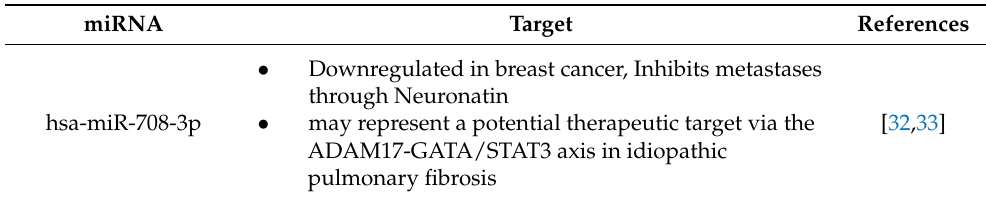
Table 2. Role and target of upregulated miRNAs in preeclampsia unique for